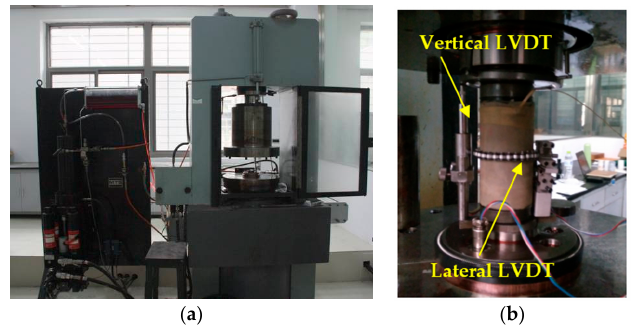
Figure 3. ( a ) MTS815.03 test machine and ( b ) Linear variable differential transformer (LVDT) installed with the sample in a heat shrinkable tube.